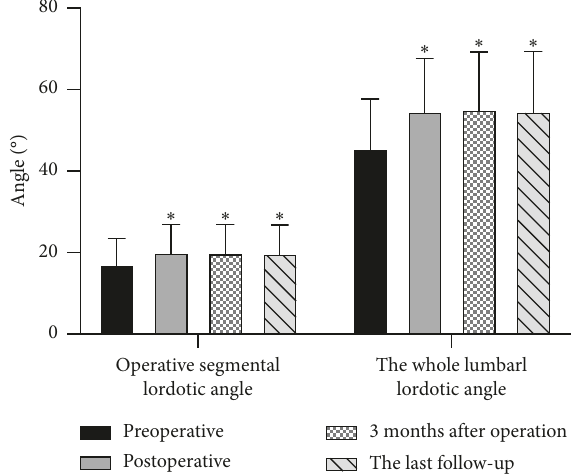
Figure 4: The comparison of sagittal angles. Compared with preoperative, lumbar lordosis angle and segmental lordosis angle increased with no loss at the last follow-up. ∗ P > 0 . 05 vs. preoperative.